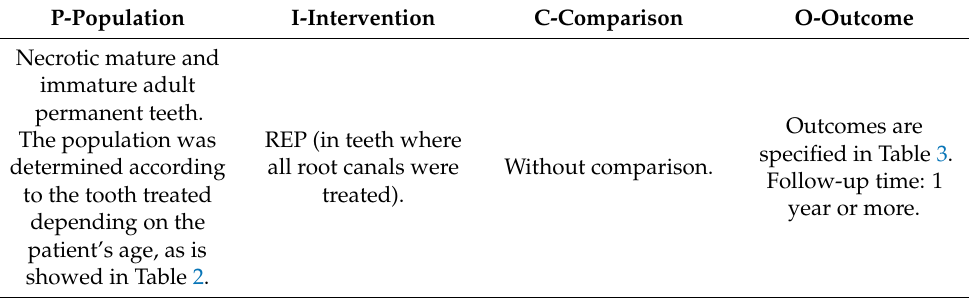
Table 1. Formulation of the specific PICO